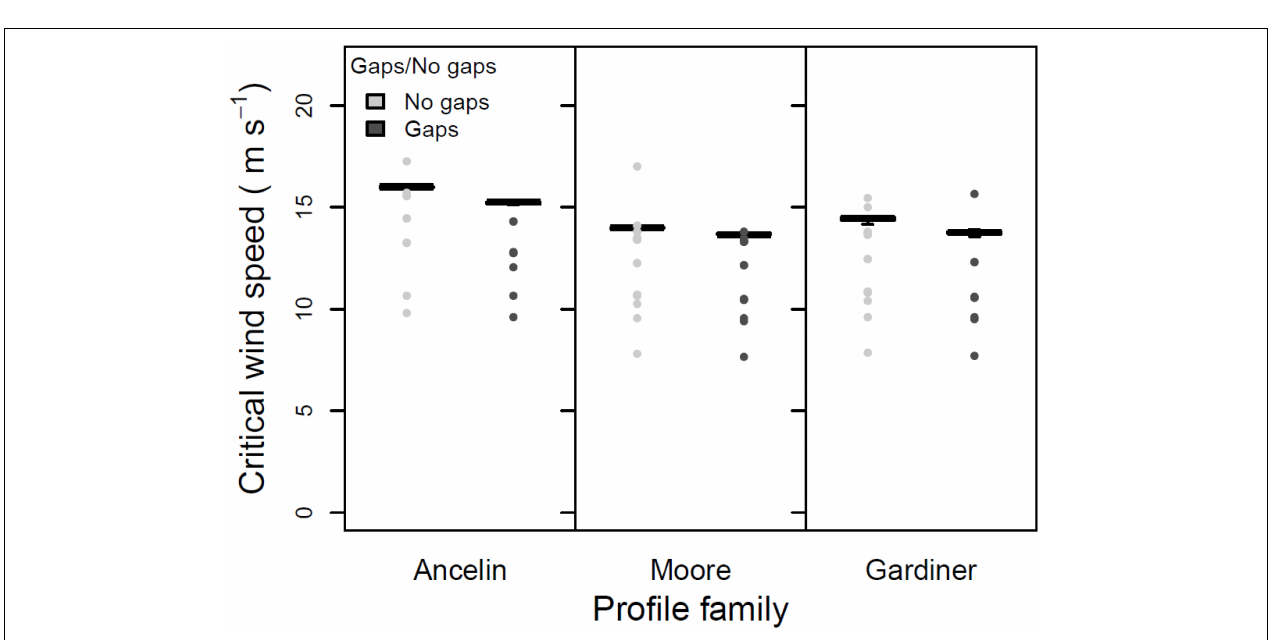
FIGURE 6 | Mean, 25 and 75% percentiles, 1.5 × interquartile range (whiskers), and outliers of critical wind speed (CWS) in m s − 1 , for three profile families, with and without neighbor support. Parameters constant across figure: stand orientation = A; alpha = 3.0 or LAI = 3.5; + indirect damage; + gaps.